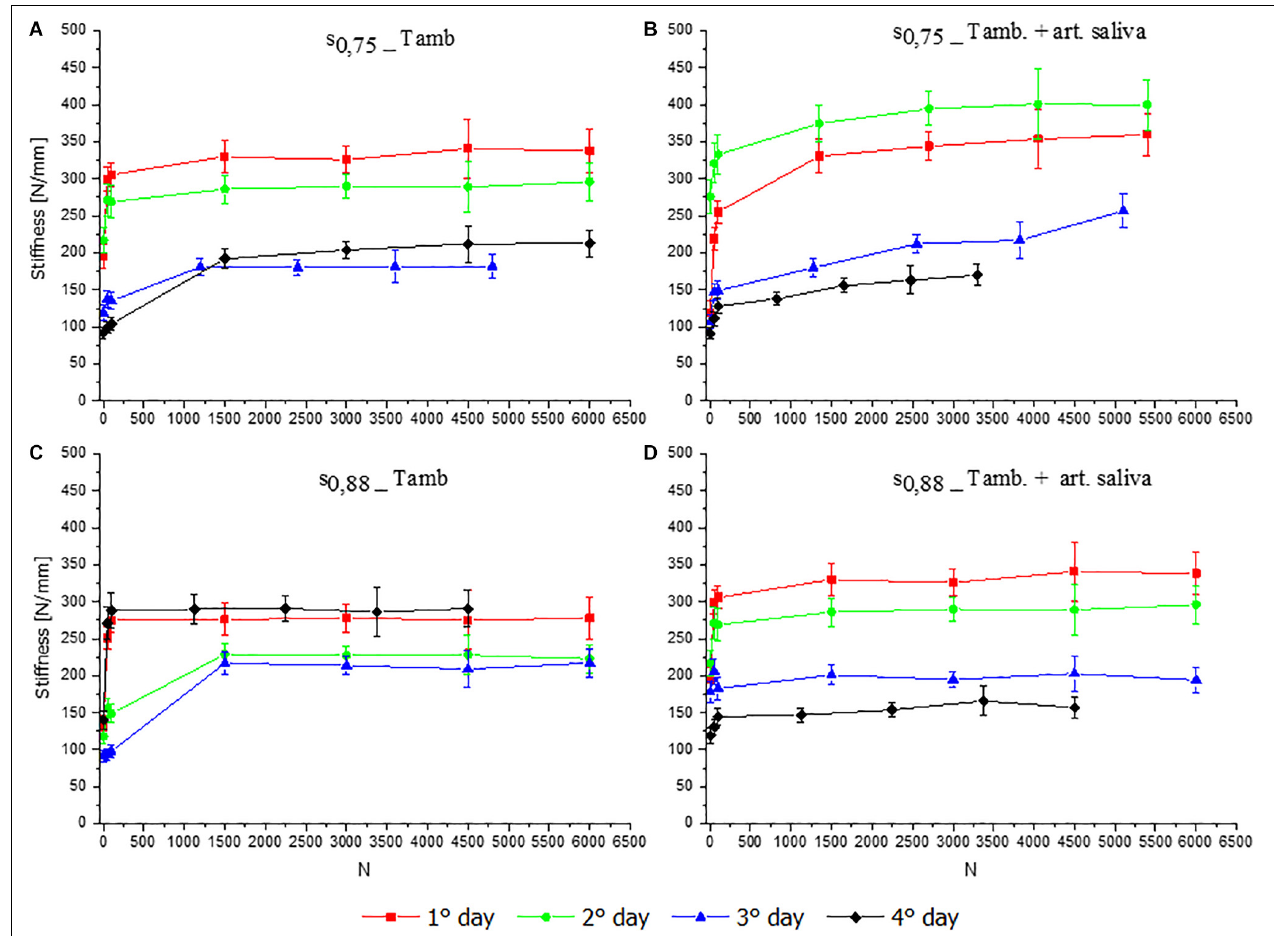
FIGURE 5 | Relative stiffness vs. number of cycles for the two copolymer thicknesses: (A) 0.75 mm sample tested in atmospheric environment ( ∼ 25 ◦ C), (B) 0.75 mm sample tested in presence of artificial saliva and at room temperature, (C) 0.88 mm sample tested in atmospheric environment ( ∼ 25 ◦ C), and (D) 0.88 mm sample tested in presence of artificial saliva and at room